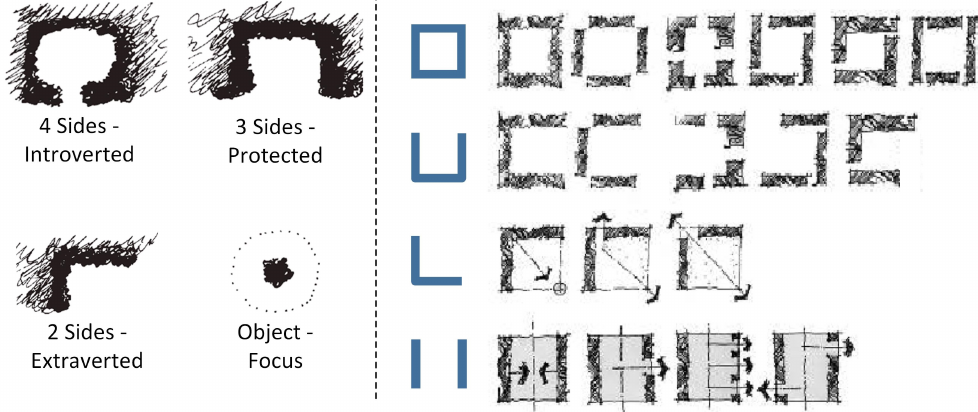
Figure 5. Space classification based on the boundary status and inner status of the space. The left figure indicates the classification based on the number of sides [88]; the right figure shows the spaces classification based on four patterns